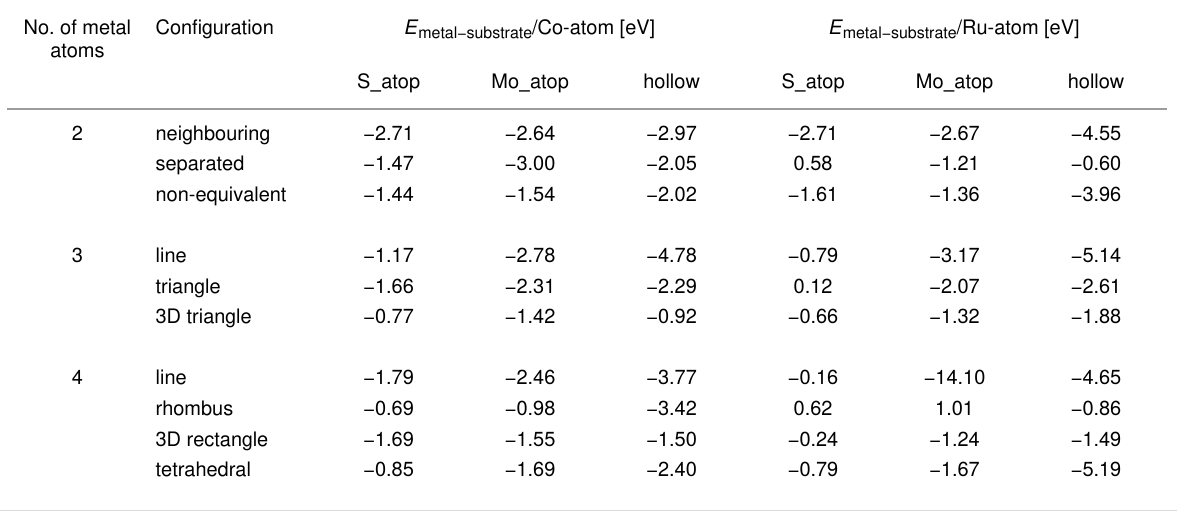
Table 2: Computed metal–substrate interaction energies for Co 2 , Co 3 , Co 4 , Ru 2 , Ru 3 and Ru 4 on a MoS 2 ML for various atom configurations using Equation 2. For the “non-equivalent” configurations for two metal atom adsorption, the column “S_atop site” has atoms at sites S_atop and Mo_atop, “Mo_atop site” has atoms at S_atop and hollow, and “hollow site” has atoms at Mo_atop and hollow.